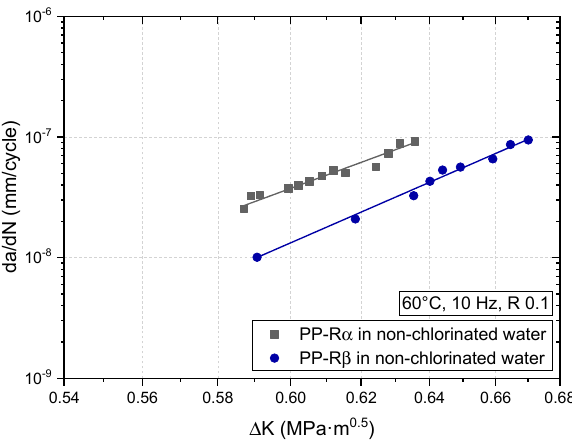
Figure 6. Crack growth curves of monoclinic α crystal type PP-R α and trigonal β crystal type PP-R β tested at 60 °C in non-chlorinated water with 0 mg/L free chlorine. tested at 60 ◦ C in non-chlorinated water with 0 mg / L free